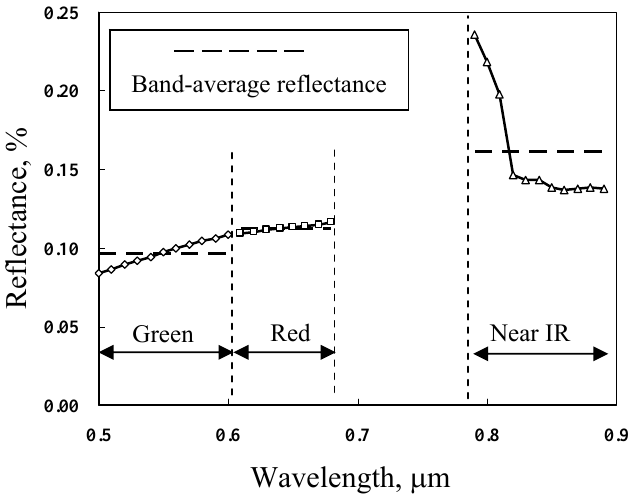
Figure 5. Calibrated RCA-average reflectances and band-average